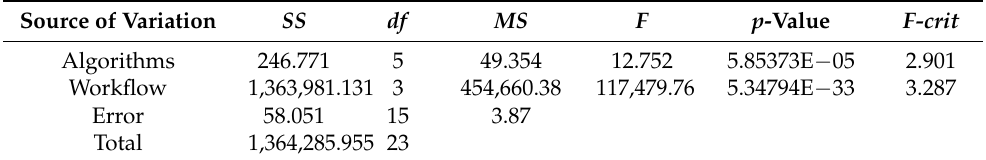
Table 9. Two way ANOVA descriptive results for Montage